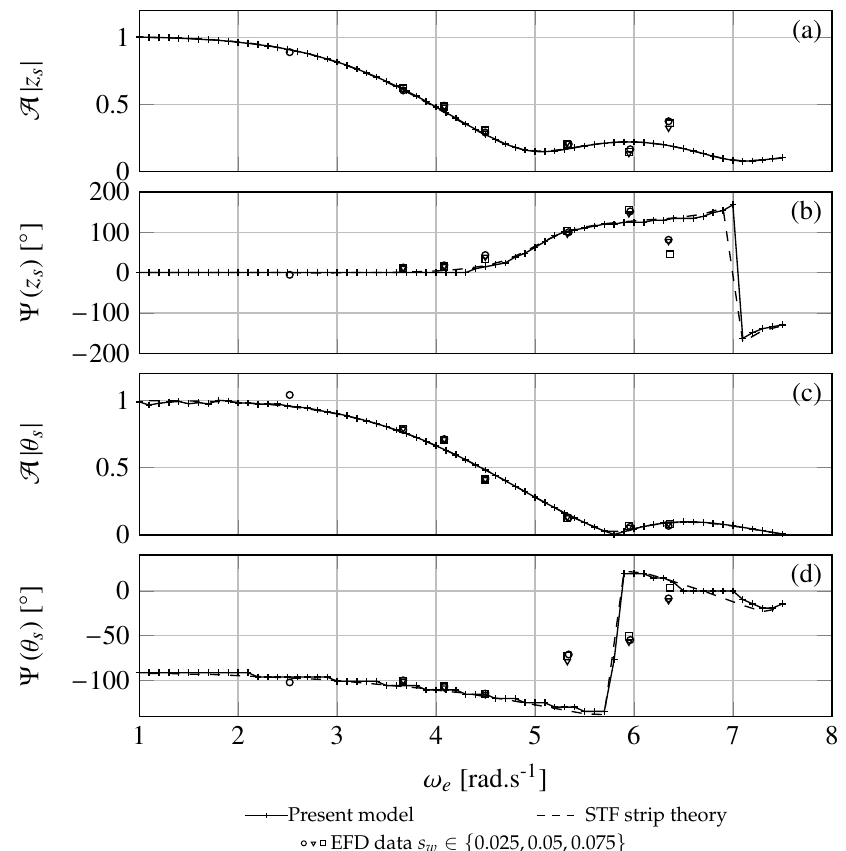
Figure 4. Heave and pitch transfer function at function of the frequency of encounter ω e . Amplitudes are plotted for heave ( a ) and pitch ( c ). Phases are plotted for heave ( b ) and pitch ( d ). The results are obtained with the frequency domain and time domain approaches, experimental data for different wave steepness s w and with the STF strip